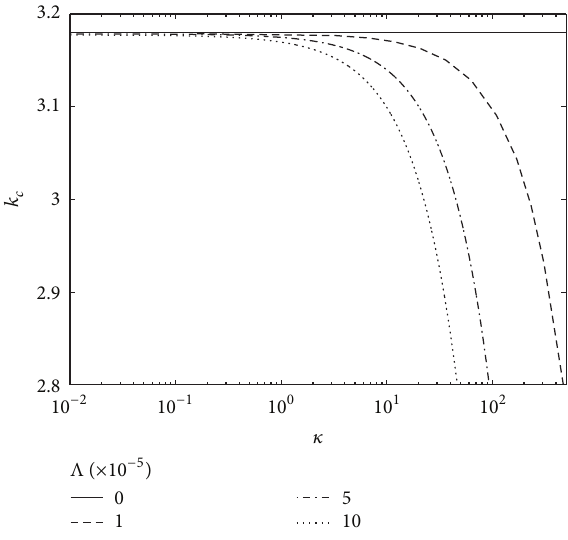
̂𝐸 = 1 , 𝜑 = Figure 3: Neutral curves for critical wave number when Λ = 10 −5 for the different values of electric field intensity